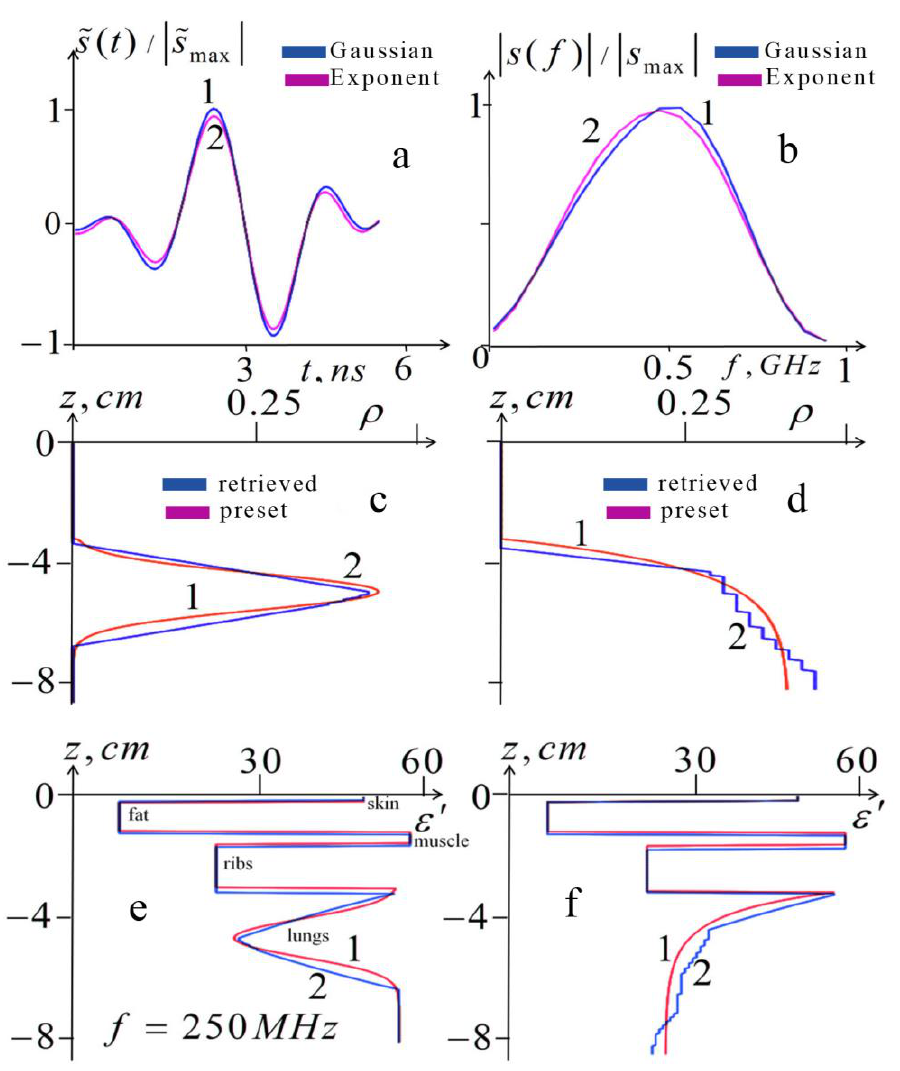
Figure 4. Numerical simulation of 1D tomography (profiling) of the lung air content and permittivity. The top row demonstrates the simulated “input data”: ( a )—modified pulse signals; ( b )—frequency spectra of modified signals. Line 1 corresponds to the simulated Gaussian profile (line 1 in Figure 4c); line 2 corresponds to the exponential profile (line 1 in Figure 4d). The middle row shows simulated (lines 1) and retrieved (lines 2) lung air content profiles ρ air ( z ) : ( c )—Gaussian preset, and retrieved from the data in Figure 4a (line 1) profiles; ( d )—exponential preset and retrieved from the data in Figure 4a (line 2) profiles. The lower row shows the preset (lines 1) and retrieved (lines 2) profiles of the real part of the thorax permittivity ε (cid:48) ( z ) at a frequency f = 250 MHz, which combine the structure of the chest cover reconstructed from (4) and the permittivity profiles in the lungs: ( e )—profiles correspond to the Gaussian profiles in Figure 4c; ( f )—profiles correspond to the exponential profiles in Figure 4d.